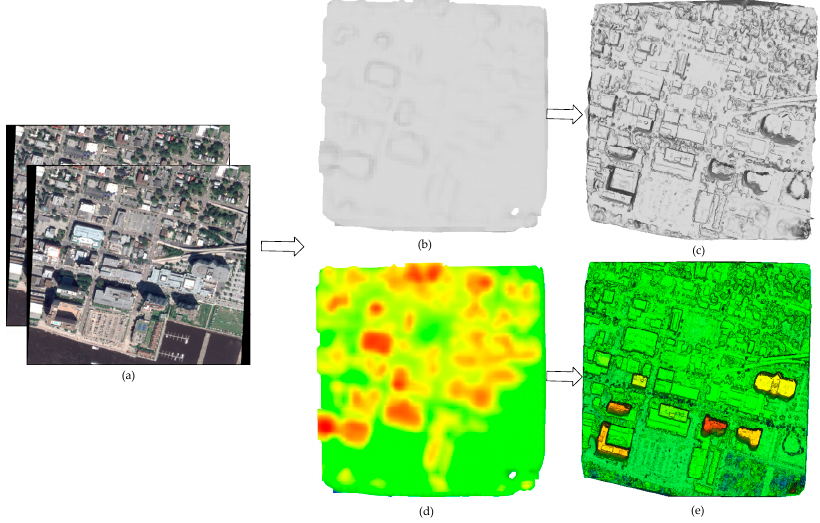
Figure 7. Results of the two views: ( a ) original image pair, ( b ) coarse mesh generated by the pair, ( c ) the result after refinement (grayscale rendering), ( d ) coarse mesh (color rendering), ( e ) refined result (color rendering).